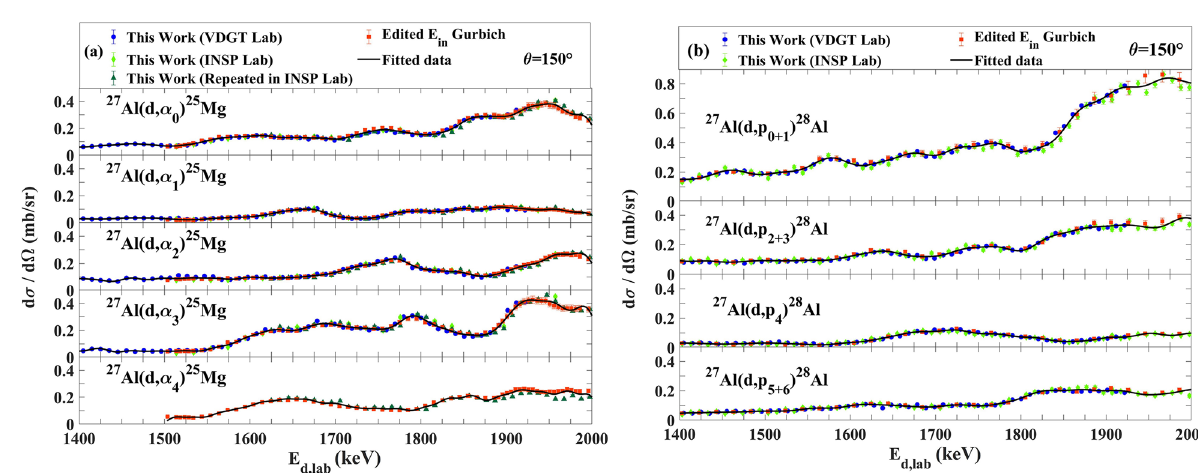
Figure 13. The fitted data for 150° for ( a ) 27 Al(d,α 0,1,2,3,4 ) 25 Mg and ( b ) 27 Al(d,p 0+1,2+3,4,5+6 ) 28 Al